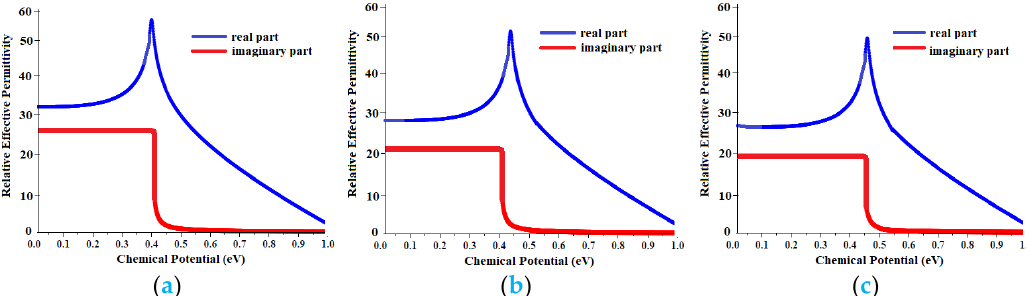
Figure 9. The real and imaginary parts of the graphene dielectric permittivity for ( a ) Antenna-1, ( b ) Antenna-2, and ( c ) Antenna-3 as the functions of the chemical potential.